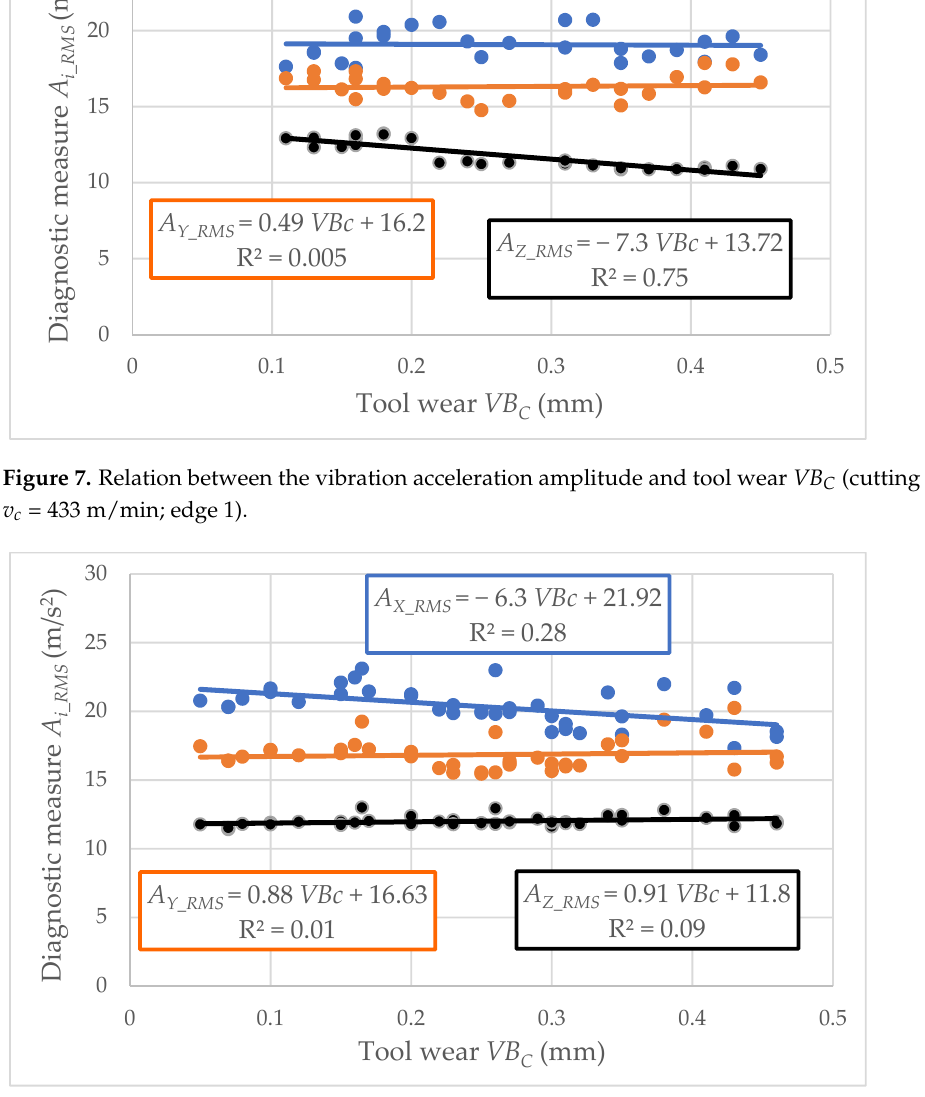
Figure 8. Relation between the vibration acceleration amplitude and tool wear VB C (cutting speed v c = 433 m/min; edge 2).